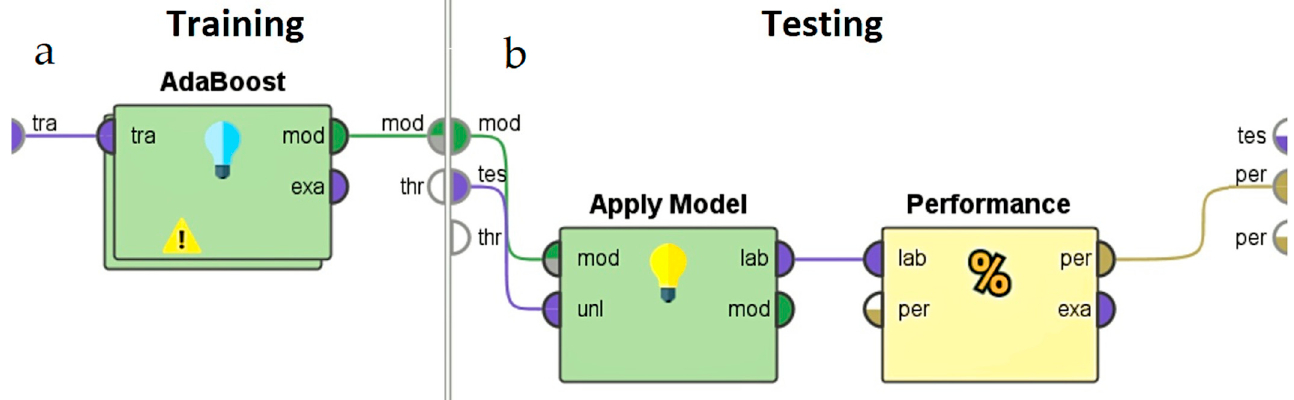
Figure 5. The process that we developed in RapidMiner using the cross-validation approach and the AdaBoost algorithm. The AdaBoost algorithm was a subprocess of the cross-validation operator, as shown in Figure 6a.